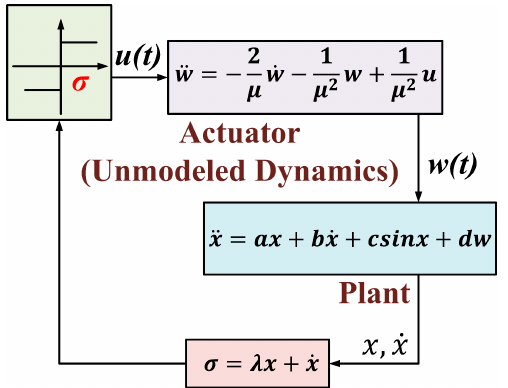
Figure 14. An example system demonstrating sliding mode control for systems as described in Equations (85) and (86). There are actuator dynamics that are not included in the ideal system. Chattering is caused from the excitation of these unmodeled dynamics by the high frequency switching action.